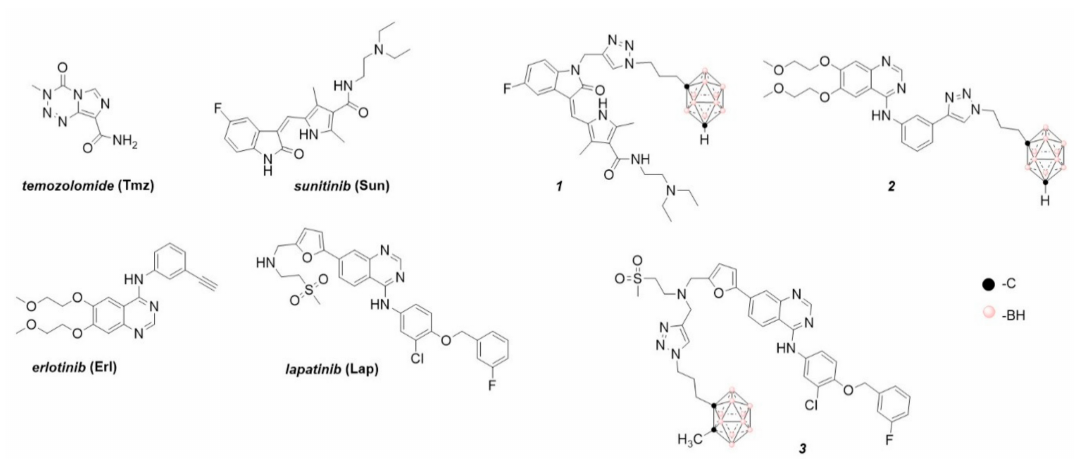
Figure 1. Chemical structures of glioblastoma drug temozolomide ( Tmz ); some relevant tyrosine kinase receptor inhibitors, sunitinib ( Sun ), erlotinib ( Erl ), and lapatinib ( Lap ); and a previous hybrid TKI–boron cluster